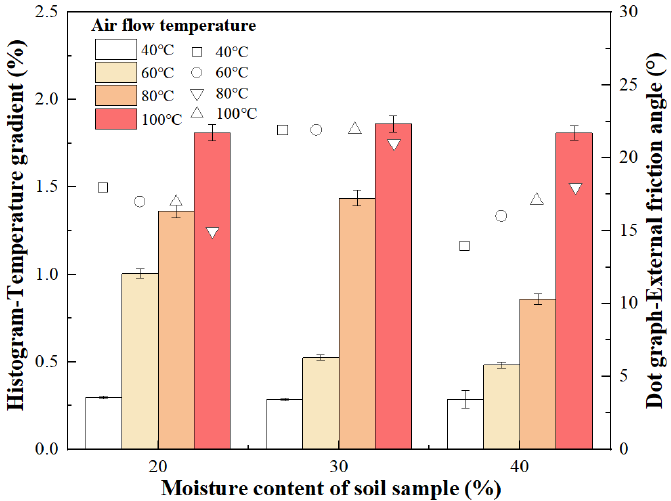
Figure 12. Effect of temperature gradient on the external friction angle.